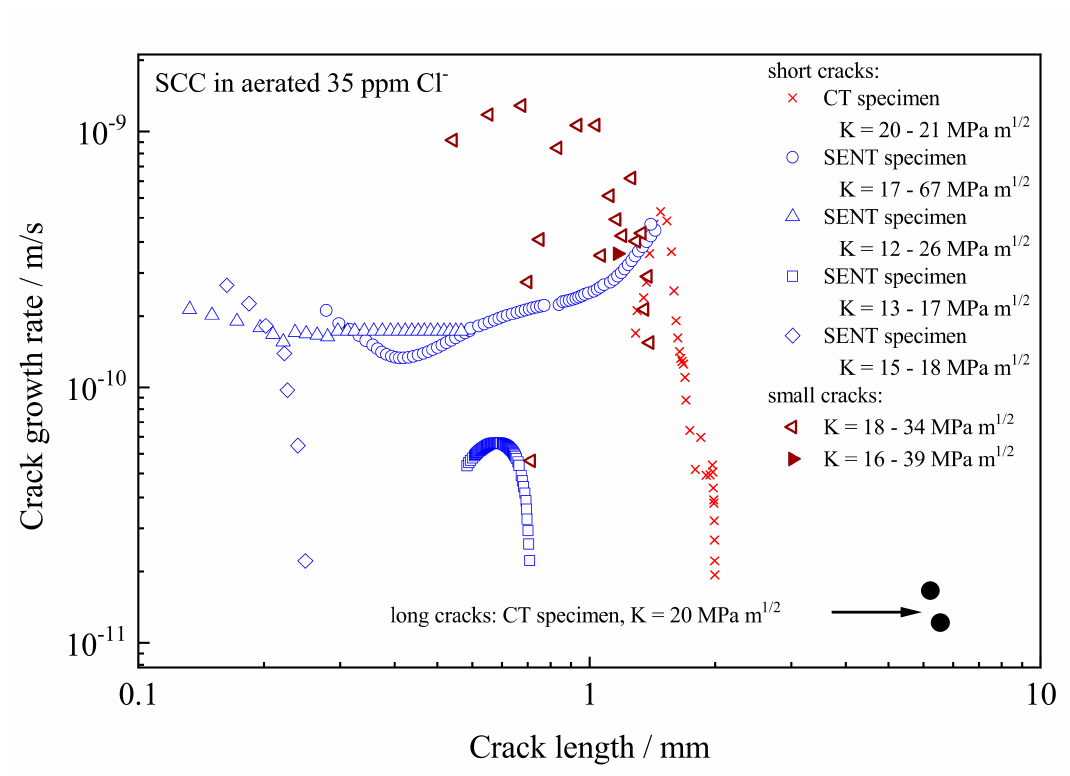
Figure 8. Stress corrosion crack growth rates for FV566 12Cr MSS in aerated 35 ppm Cl − at 90 ◦ C [26]. Reproduced by permission from De Gruyter